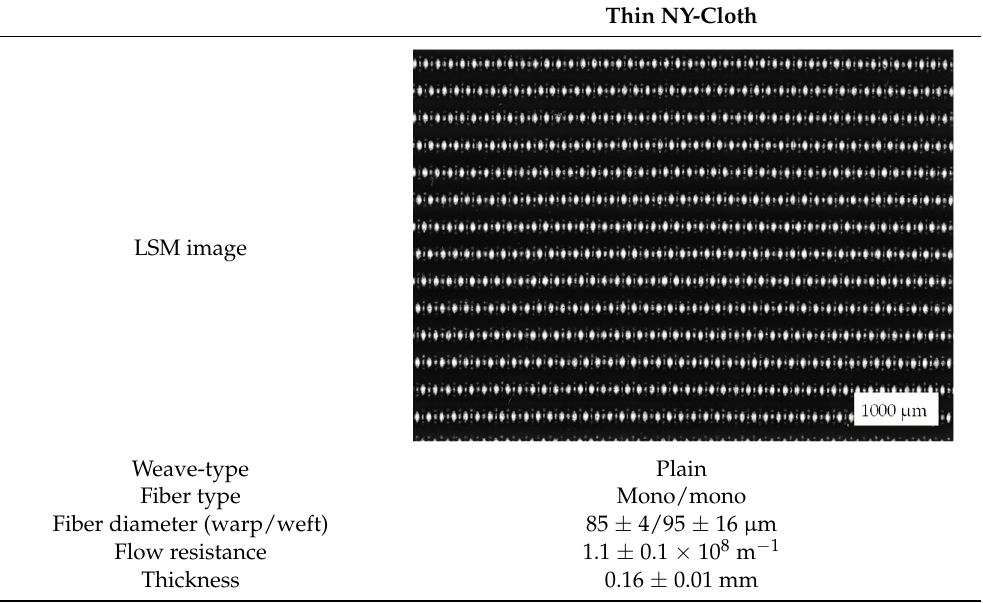
6 Figure 4. Overview of abrasion test for apparatus parameter evaluation and tailings filter media